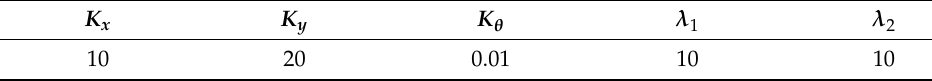
Table 3. Kinematic control parameters.